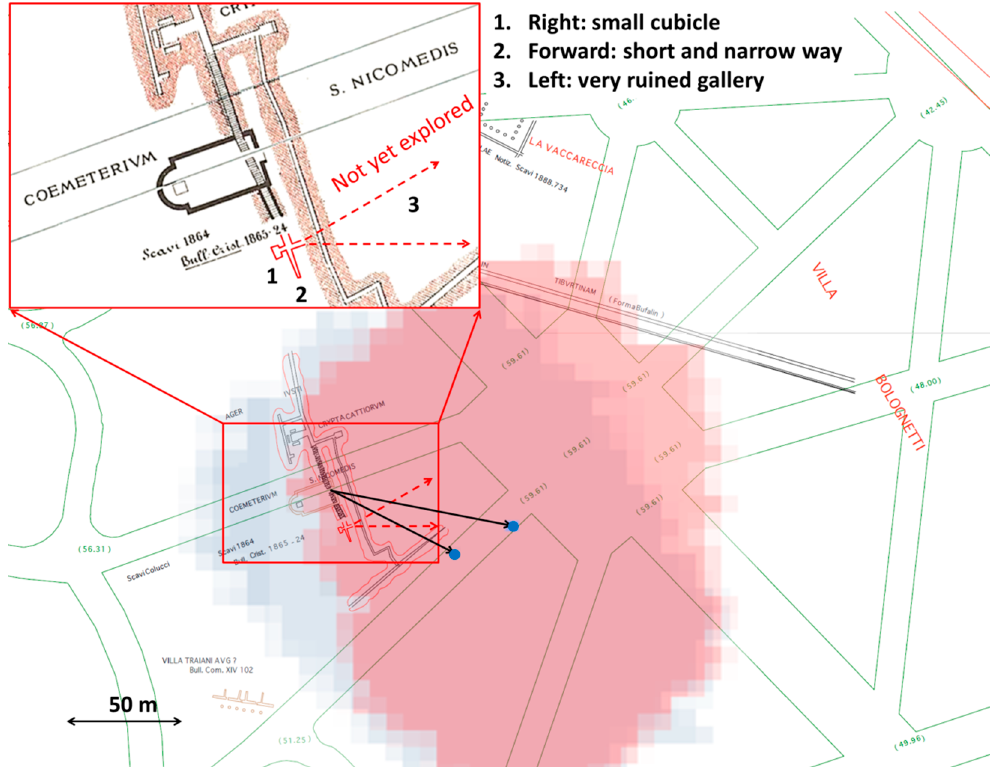
Figure 13. Superposition, on the maps of Lanciani [54], of our reconstruction of Peter’s first burial site, obtained from the analysis of Maria Valtorta’s MWs. The gray (light red) cloud represents the result obtained from Monte Carlo simulations shown in Figure 11a (Figure 11b). The intersection of the two clouds is shown with a darker red color. The enlargement at the top left shows the two stairs that descend to the two hypogea: the northernmost one at St. Nicomedes (the current Anonymous Hypogeum); the southernmost one to the hypogeum not fully explored, of which we have reported an indicative diagram in red obtained from its description made by De Rossi [62].